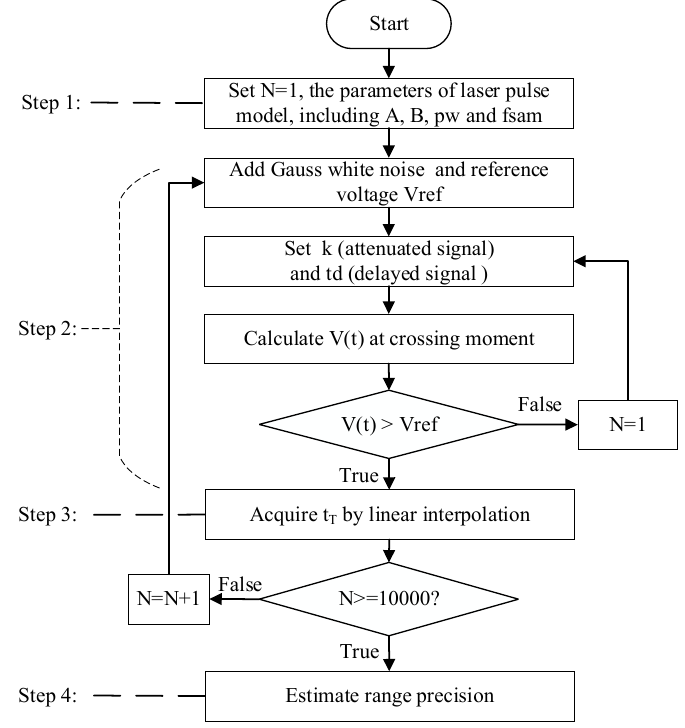
Figure 6. Flow diagram of Monte Carlo simulation for estimating the range precision.